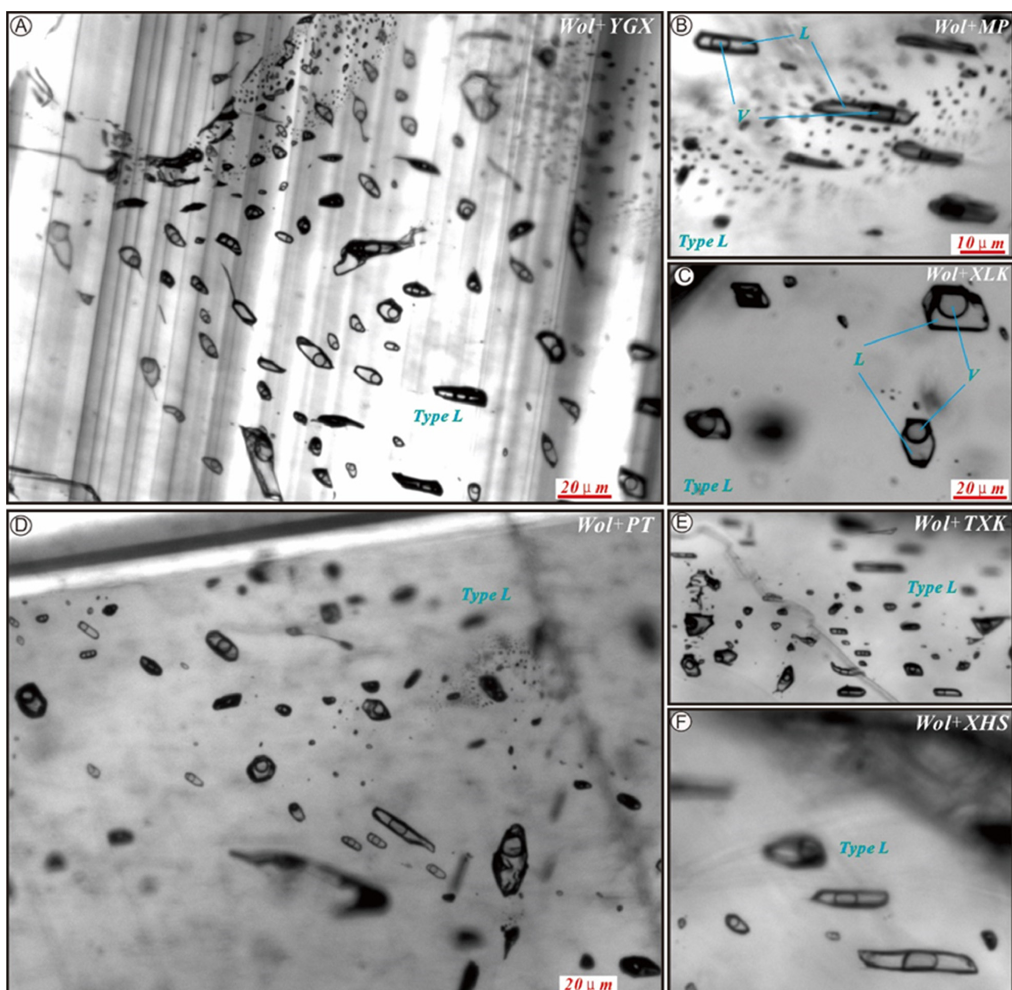
Figure 7. Photomicrograph of representative fluid inclusions captured in wolframite from wolframite-quartz vein-type tungsten deposits in South China. Pictures show typical two-phase liquid-rich fluid inclusion assemblages in wolframite from the Yaogangxian ( A ), Maoping ( B ), Xingluokeng ( C ), Piaotang ( D ), Taoxikeng ( E ) and Xihuashan ( F ) tungsten deposits, respectively. Abbreviations: Wol—Wolframite YGX—Yaogangxian; MP—Maoping; XLK—Xingluokeng; PT—Piaotang; TXK— Taoxikeng; XHS—Xihuashan; L—liquid; V—vapor.